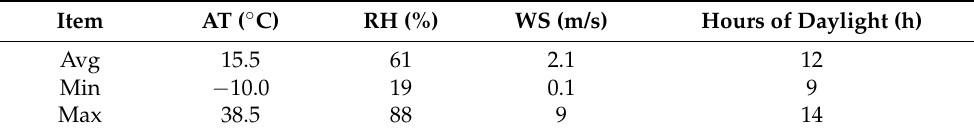
Table 1. Historical weather in Xi’an (from May 2020 to May 2021).